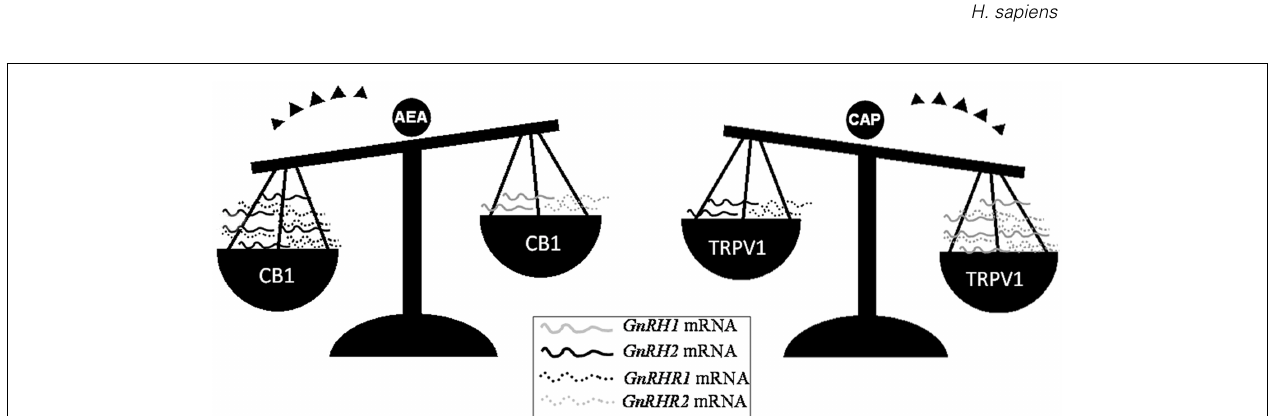
intracellular AEA also bindTRPV1, the involvement of AEA in the modulation of testicular GnRH signaling may occur via the selective activation of different eCB